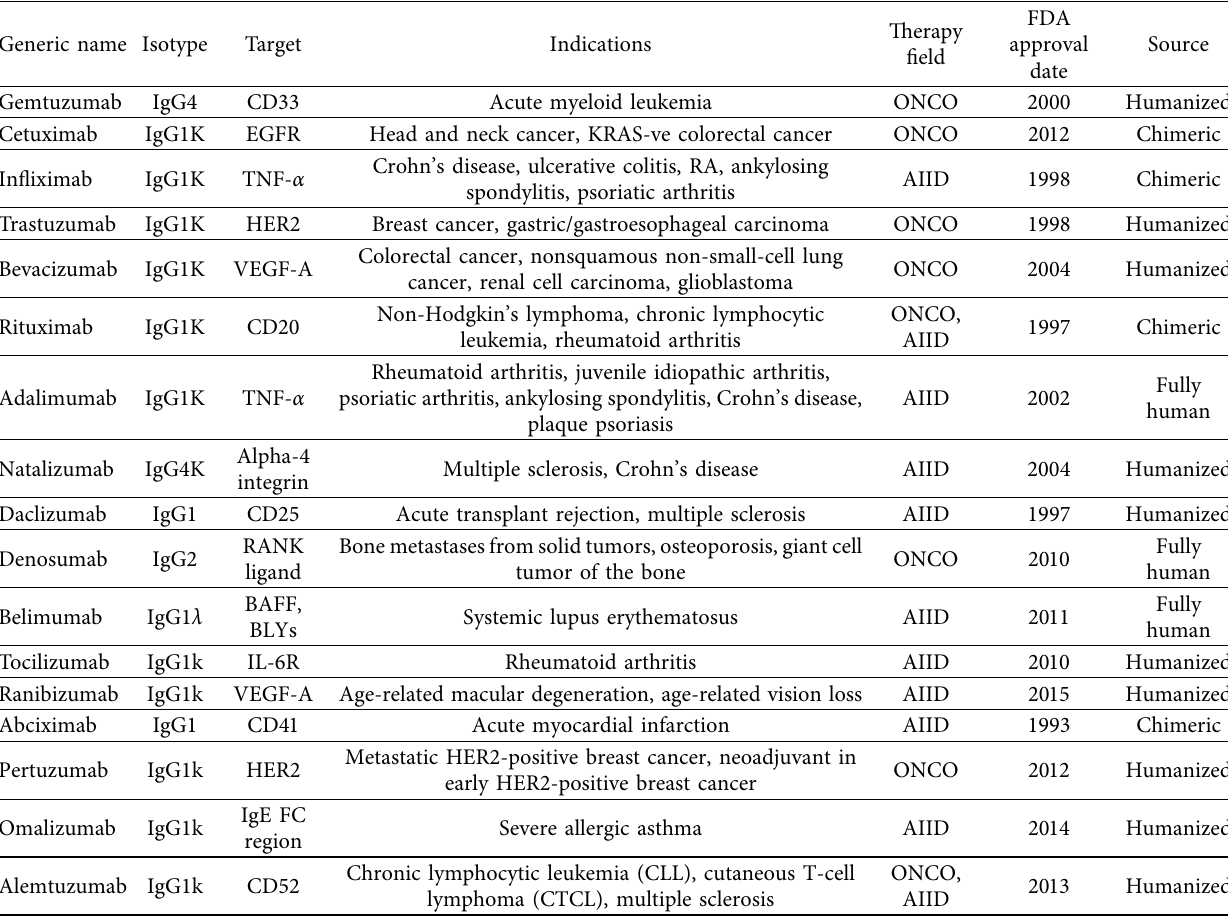
Table 1: Characterization of monoclonal therapeutic antibodies (MTAs) used from 2007 to 2018 in Iran. Generic name